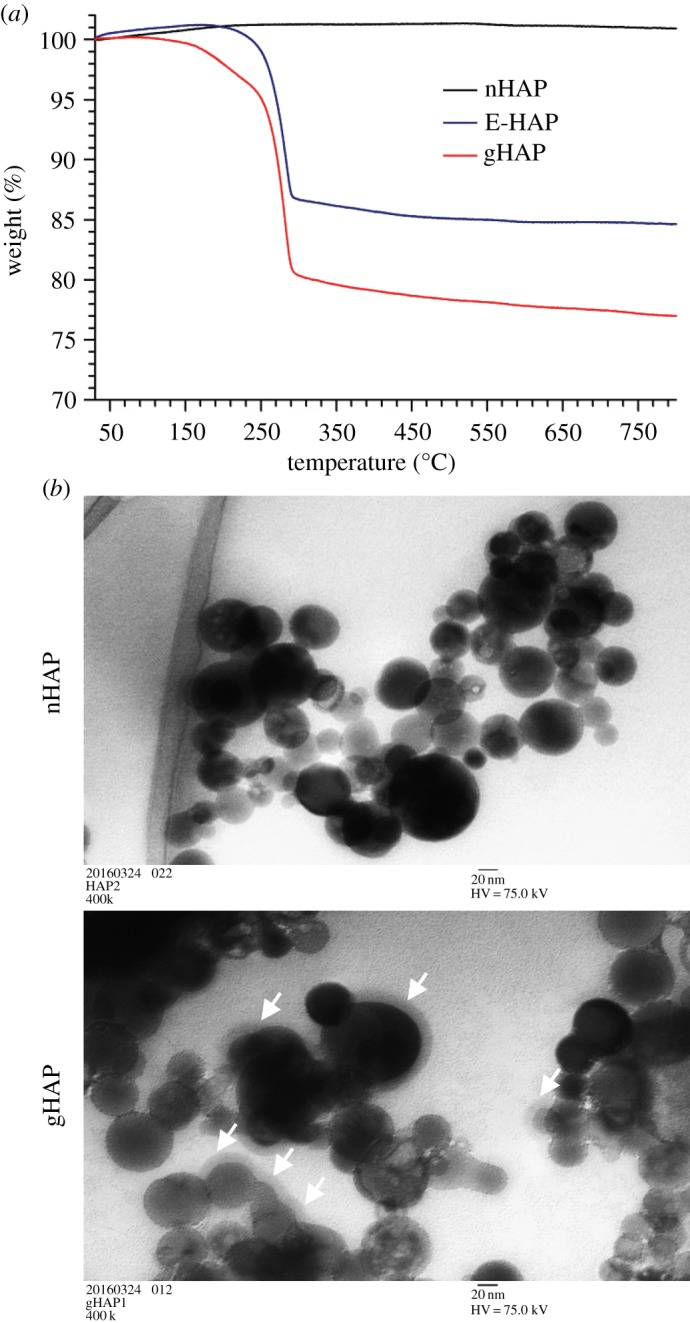
Grafting ratio and morphology change before and after surface polymer modification. (a) TGA results of HAP without grafting (nHAP) in black, ethylene glycol-grafted HAP (E-HAP) in blue and PCL-grafted E-HAP (gHAP) in red. (b) TEM images of nHAP and gHAP. White arrows point out the corona ring.